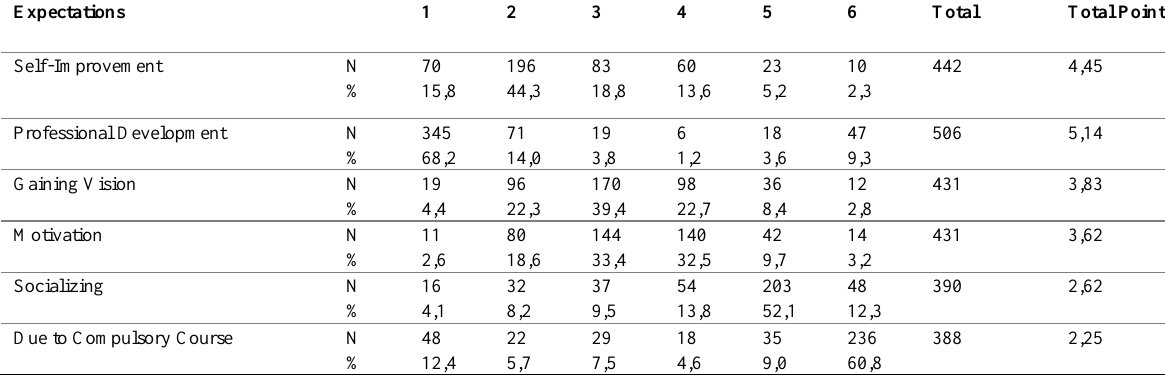
Table 13: Expectations from In-Service